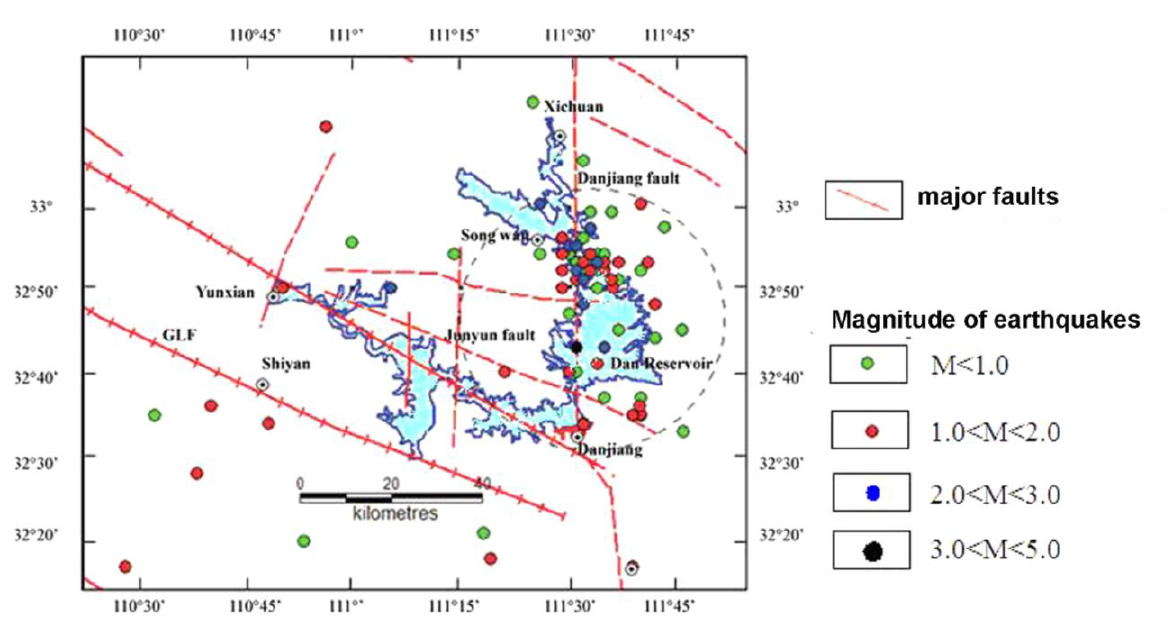
Fig. 3. Seismicity distribution before Danjiangkou reservoir filling (1959-1967) in central China (based on Liu et al., 2011)